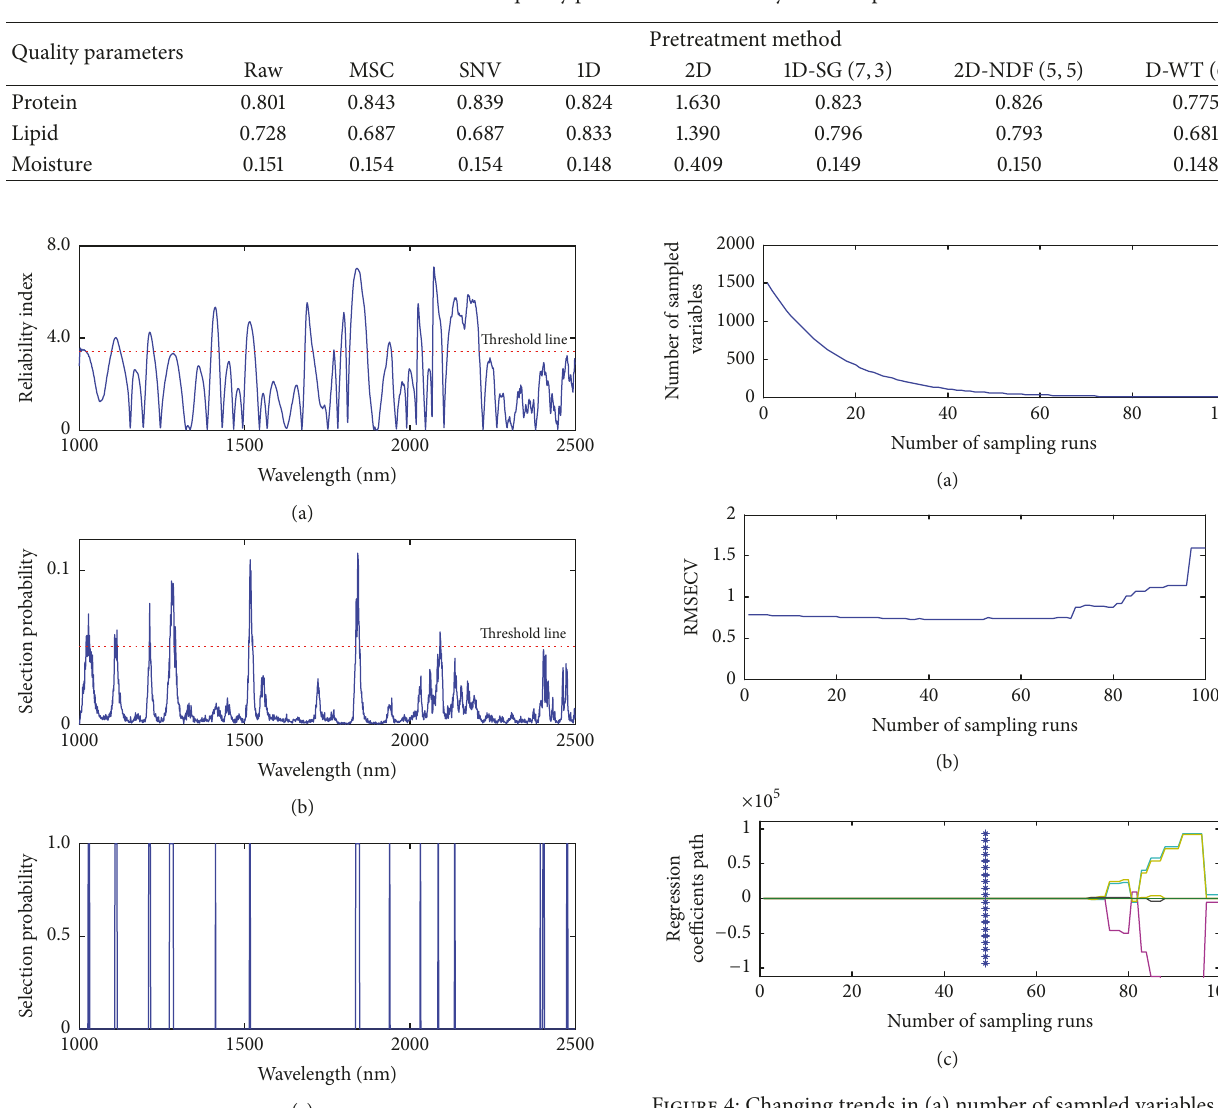
Table 2: Lowest RMSECV values of quality parameters obtained by different pretreatment methods.